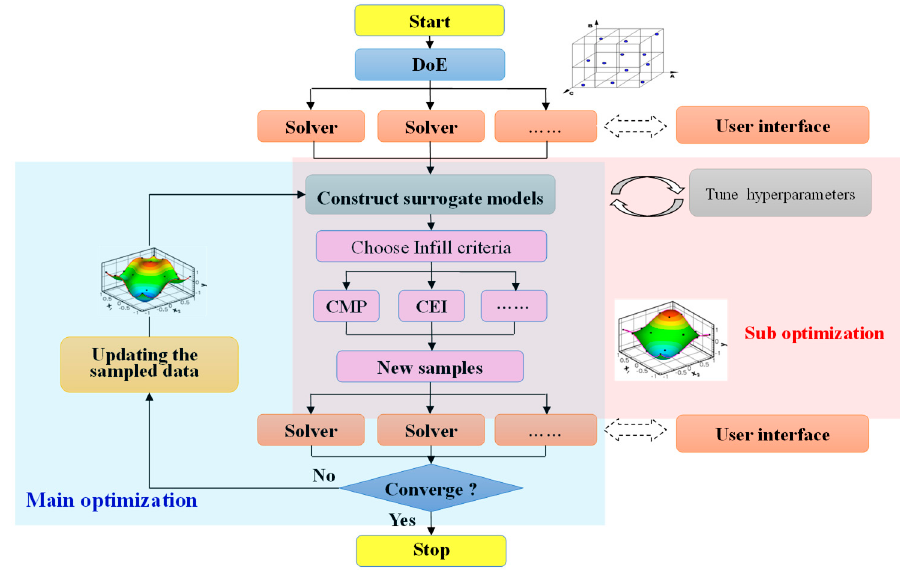
Figure 14. Framework of the efficient surrogate-based optimizer: SurroOpt.